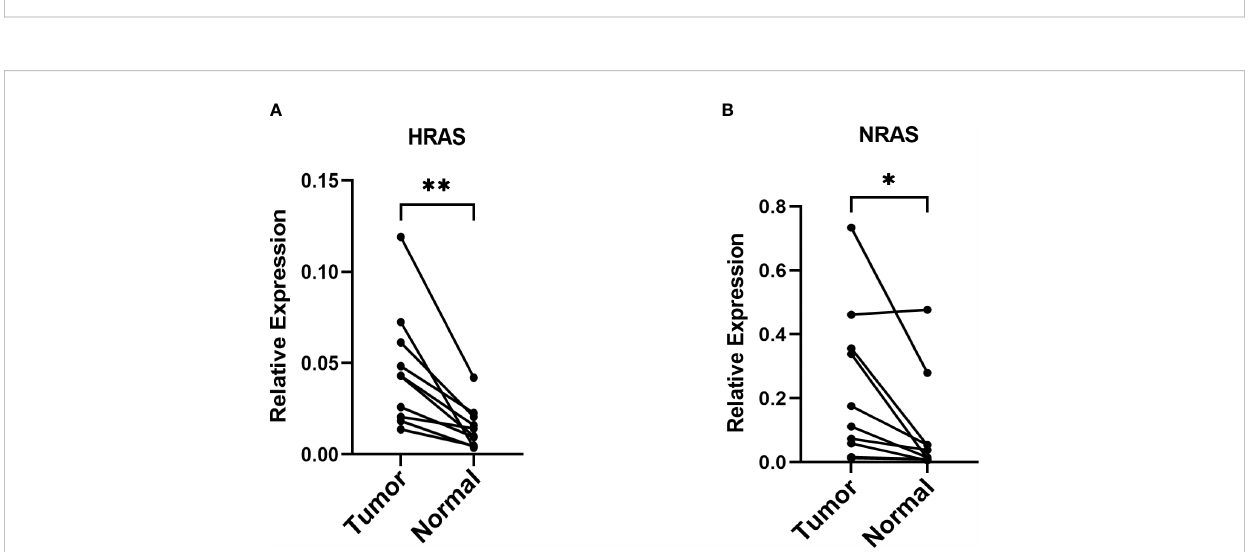
FIGURE 12 The mRNA relative expression of genes in the risk model (A, B) The mRNA relative expression of HRAS and NRAS in paired tumor tissues with b -actin as an internal control. *P< 0.05; **P<